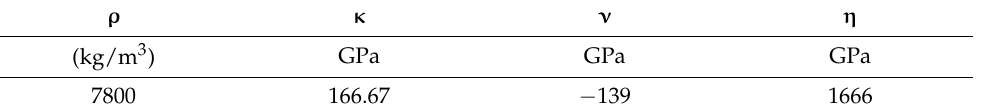
Table 3. Specimens’ material properties: density, ρ ; bulk modulus, κ ; second-and third-order single- crystal anisotropy coefficients, ν and η.